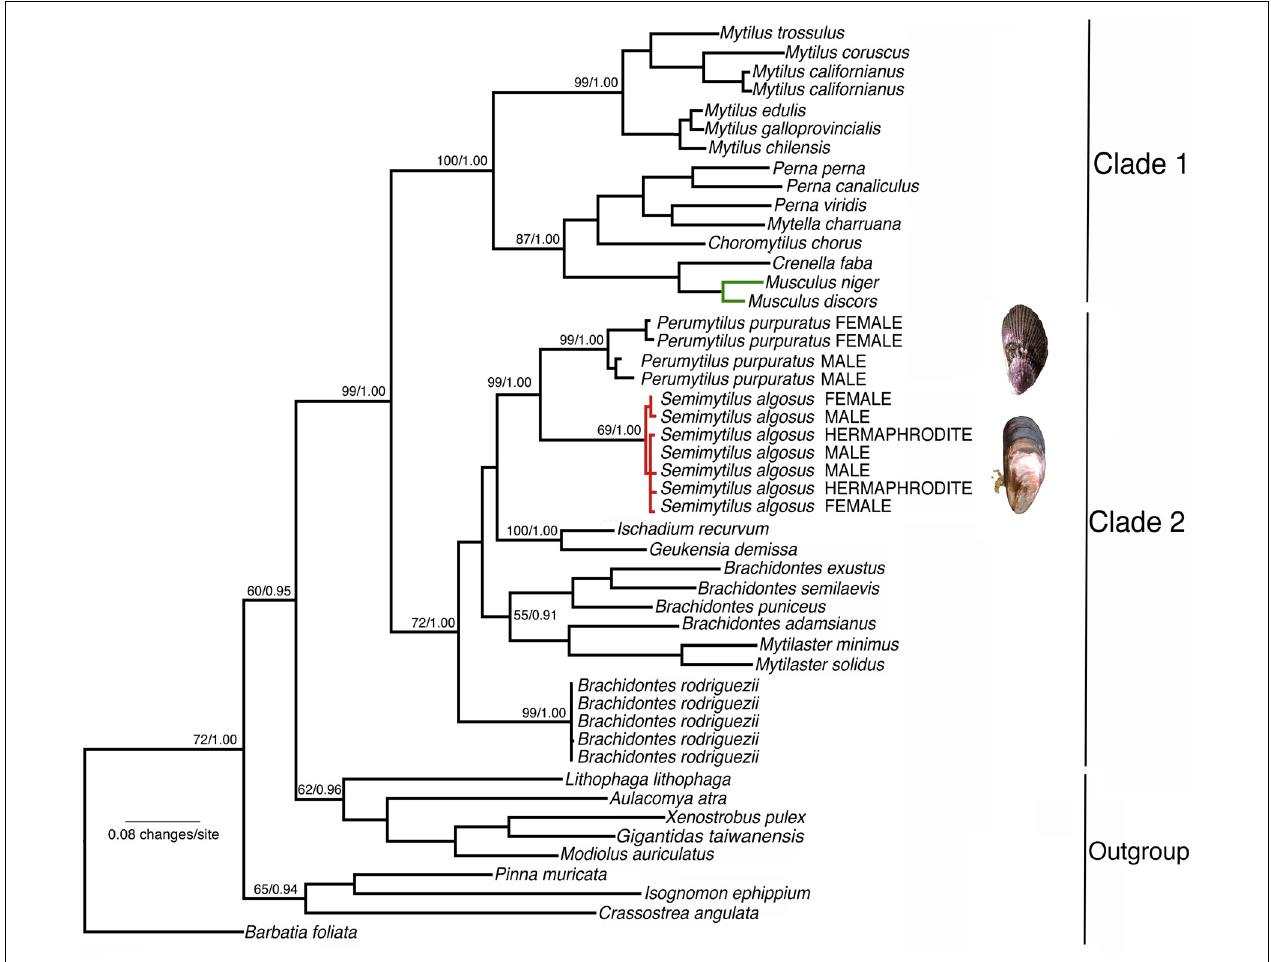
FIGURE 2 | Maximum likelihood tree of the relationships amongst mussels of the family Mytilidae based on cytochrome oxidase subunit I (COI) sequence variation (Bayesian analysis returned the same topology). Numbers above the branches are maximum likelihood bootstrapping scores/Bayesian posterior probabilities. Green = hermaphrodite species; red = trioecy species. The GenBank accession numbers are given in Supplementary Table S1